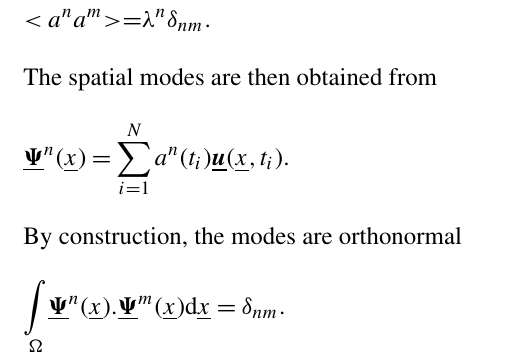
Figure 7. Evolution of the relative angle of attack (cid:49)α during an os- cillation cycle. ( x ): instantaneous velocity fields detailed in Figs. 8 and